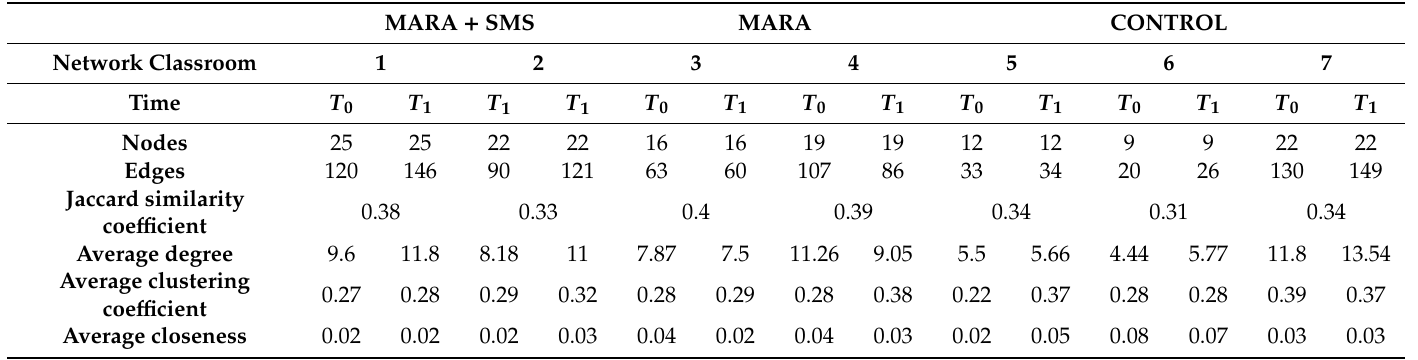
Table A2. Friendship network characteristics for two time-points in the three di ff erent schools of the study. Network characteristics are explained in the Methods section. MARA + SMS MARA